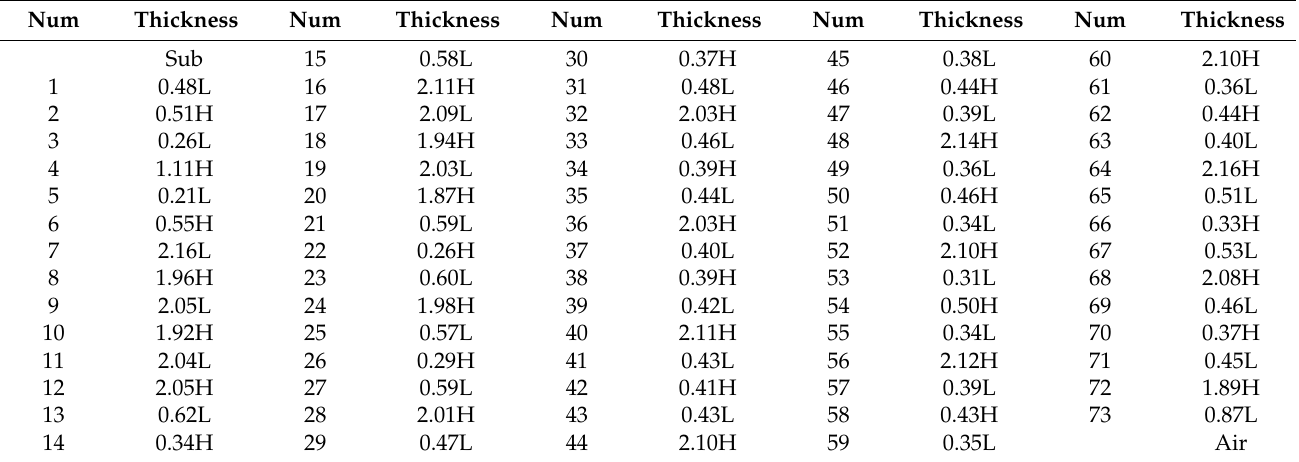
Table 2. Thin-film structure and film